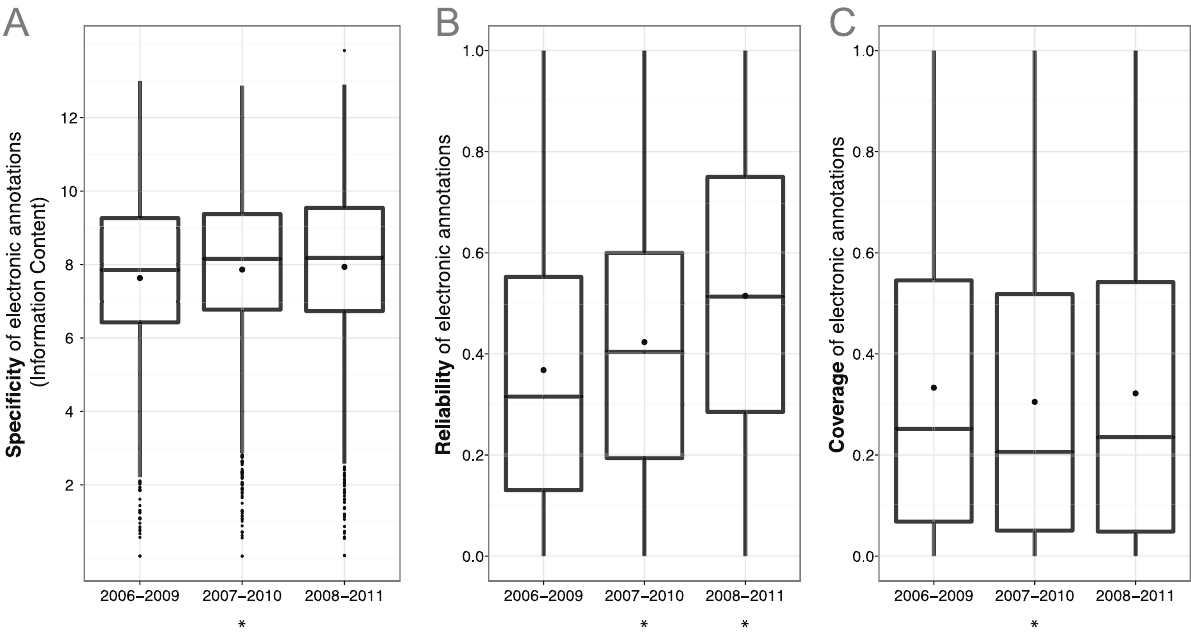
Figure 3. Summary statistics of GO terms: (A) specificity, (B) reliability, and (C) coverage. Each boxplot summarizes the measure of quality indicated on the y-axis for the evaluation period indicated on the x-axis. Lower, mid, and upper horizontal lines denote the first quartile, median and the third quartile, respectively, while the black dots denote the mean values. Outliers (further than 1.5 interquartile range from the respective quartile) are denoted by black points. An asterisk (*) below the boxplot denotes a significant difference of the median with respect to the previous interval, at a confidence level of 0.05 (Mann-Whitney U test, two-tailed).